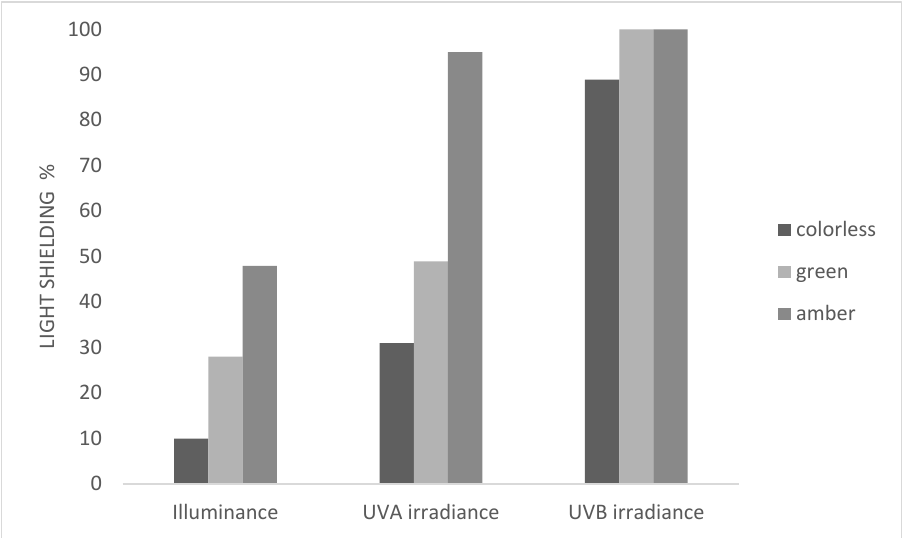
Figure 1. Light shielding (%) of clear glass bottles (colorless, green, amber).